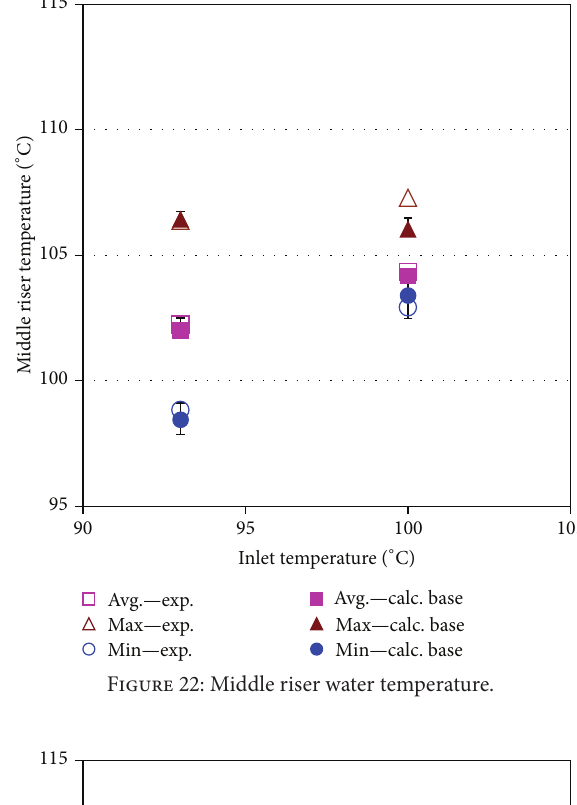
Figure 22: Middle riser water temperature.